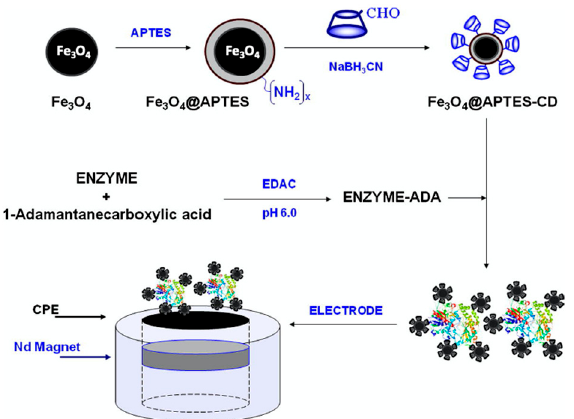
Figure 9. Illustration of the formation of magnetically anchored enzyme using CD-coated super- paramagnetic Fe 3 O 4 nanoparticles. Reproduced with permission from Diez et al. [161], J. Colloid Interface Sci.; published by Elsevier, 2012.